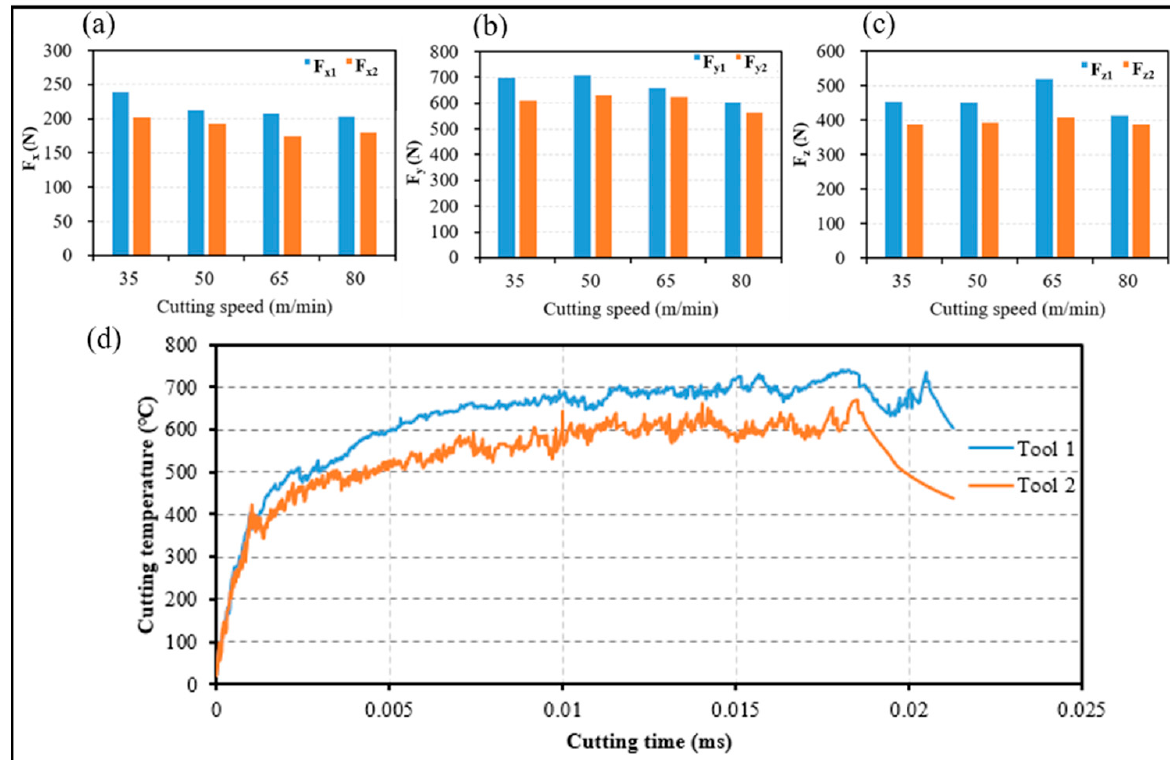
Figure 3. Comparison of cutting forces and cutting temperature for two tools: ( a ) the cutting depth resistance, ( b ) the feed resistance, ( c ) the main cutting force, ( d ) cutting temperature.